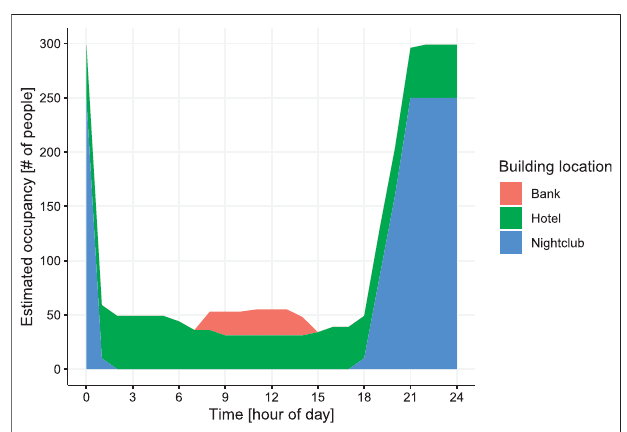
FIGURE 2 | Hotel New World estimated occupancy by hour for the day of collapse based on typical occupancy for building use and type (García Kerdan et al., 2015), as well as original estimates and accounts of persons reported missing (New York Times, 1986; National Geographic,